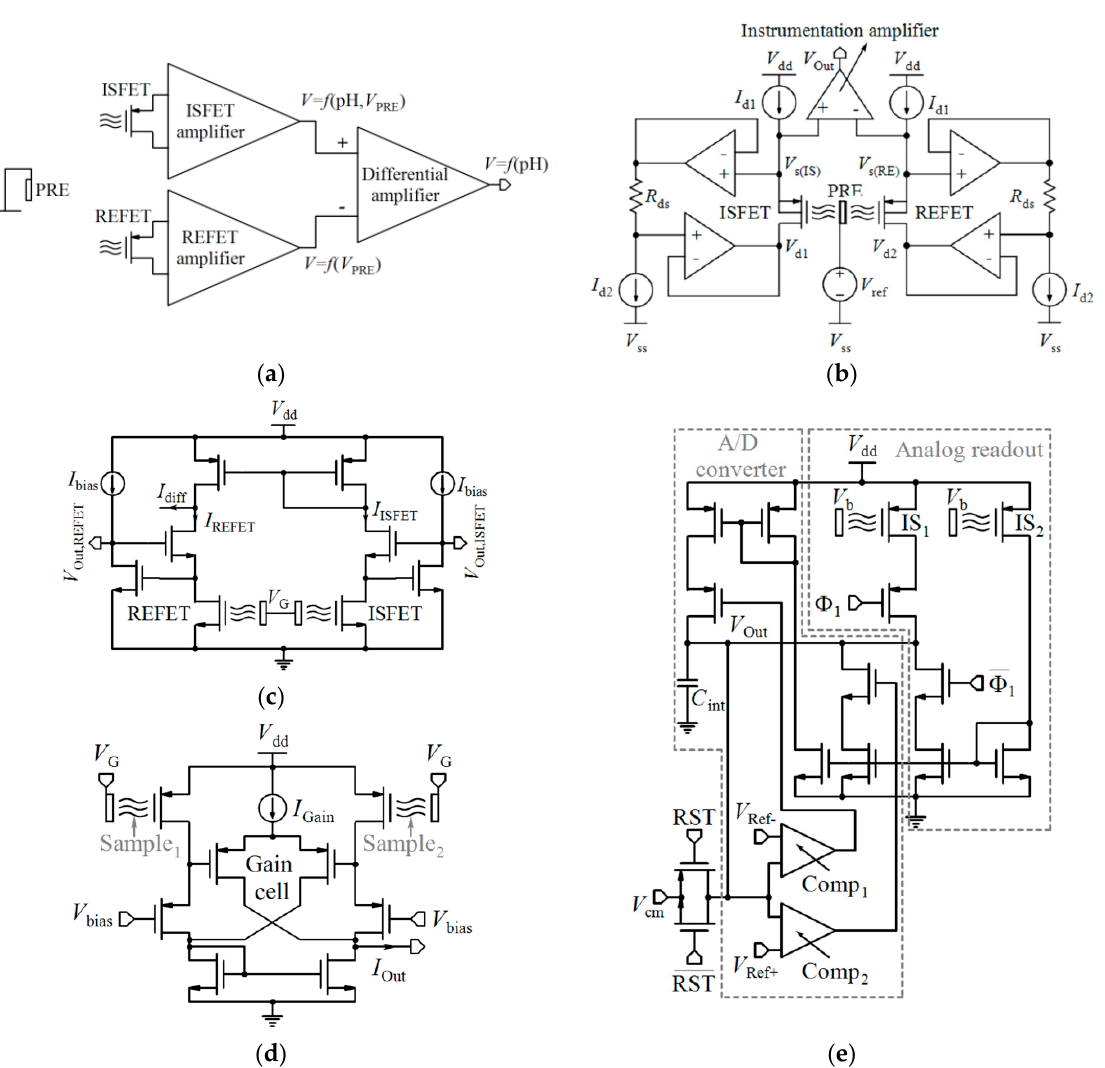
Figure 30. ( a ) A differential ISFET/reference FET (REFET) measuring system; ( b ) a differential pH-measurement pixel with ISFET and REFET for array structure; ( c ) ISFET/REFET voltage-clamped configuration; ( d ) a chemical Gilbert cell; ( e ) a ΣΔ ISFET readout circuit using differential measurement.